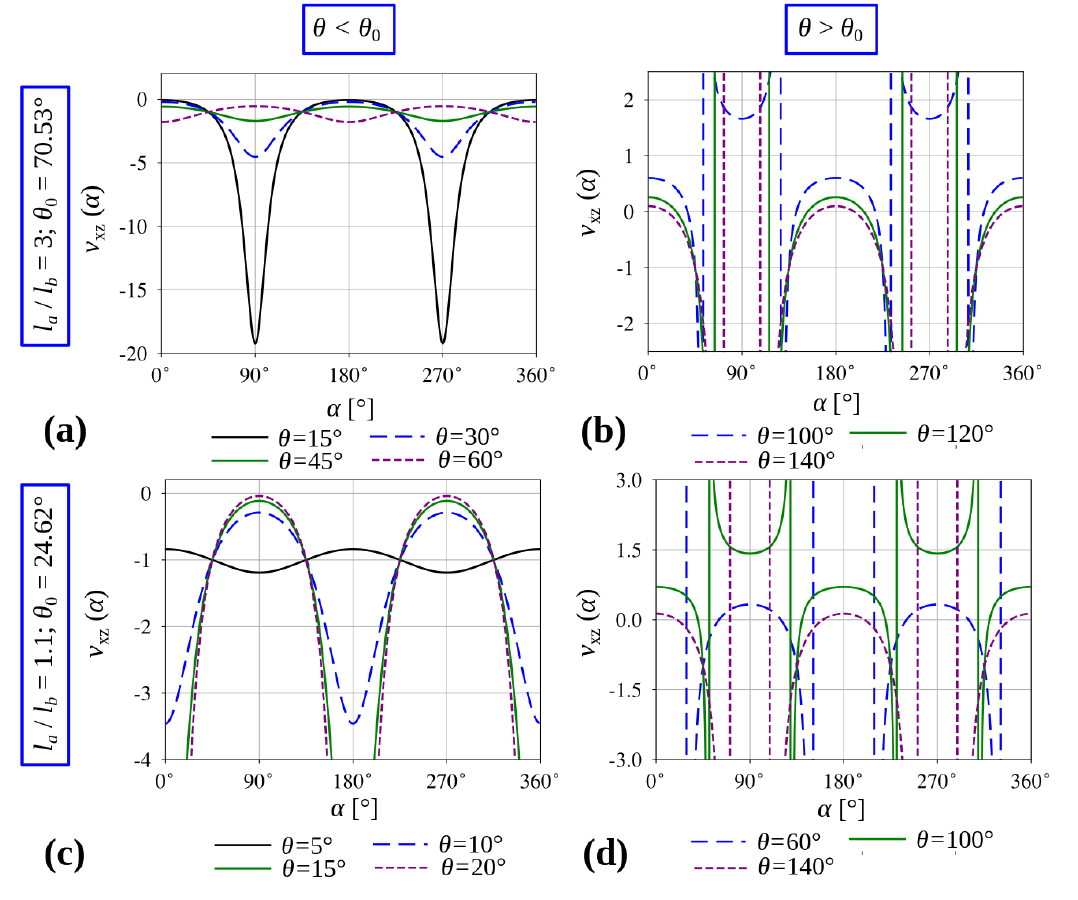
Figure 5. Poisson’s ratio for loading in an arbitrary direction in the xz plane (in the yz plane results are identical) for the system having different ratios of linear dimensions constituting the system l a / l b